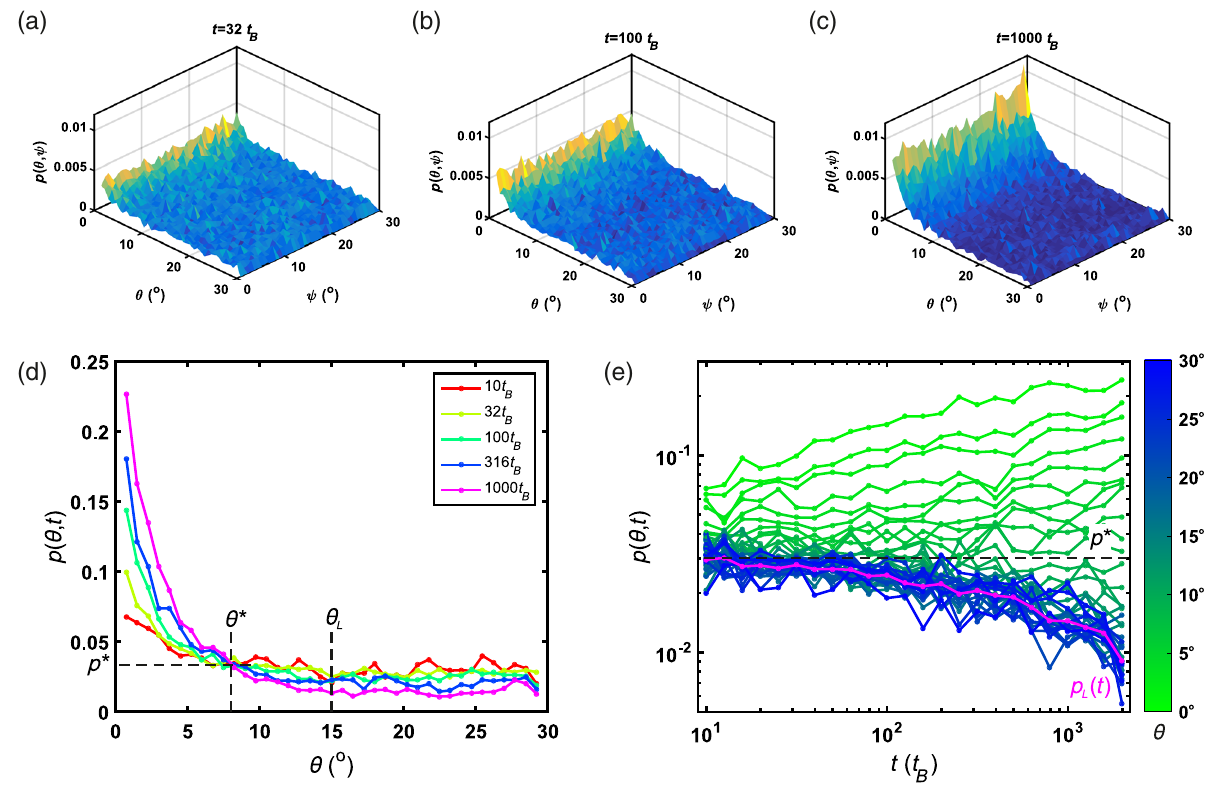
FIG. 3. (a) – (c) Grain boundary character distribution (GBCD), p ð θ ; ψ ; t Þ , as a function of the misorientation, θ , and the inclination, ψ , for three different times during coarsening. (d) The ψ -averaged GBCD, p ð θ ; t Þ , as a function of the misorientation, θ , for different times during coarsening. The LAGB regime is defined as GBs with misorientations above θ regime corresponding to the value p (cid:2) of the GBCD. (e) GBCD as a function of time for different misorientations, where each curve is colored according to the misorientation as indicated by the color bar. The time dependence of the GBCD is strongly misorientation dependent below θ , involving a transition from an increasing to a decreasing GBCD at the crossover value θ (cid:2) , where the GBCD equals L p (cid:2) . Above θ , the GBCD curves decay in the same fashion, which corresponds to an average master curve denoted p L